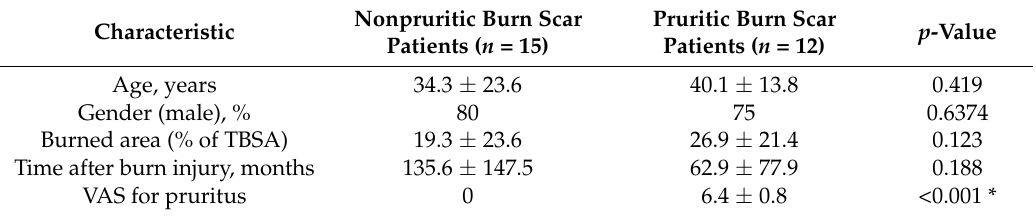
Table 1. The clinical differences between burn patients with and without pruritus. Nonpruritic Burn Scar Pruritic Burn Characteristic Patients ( n = 15)